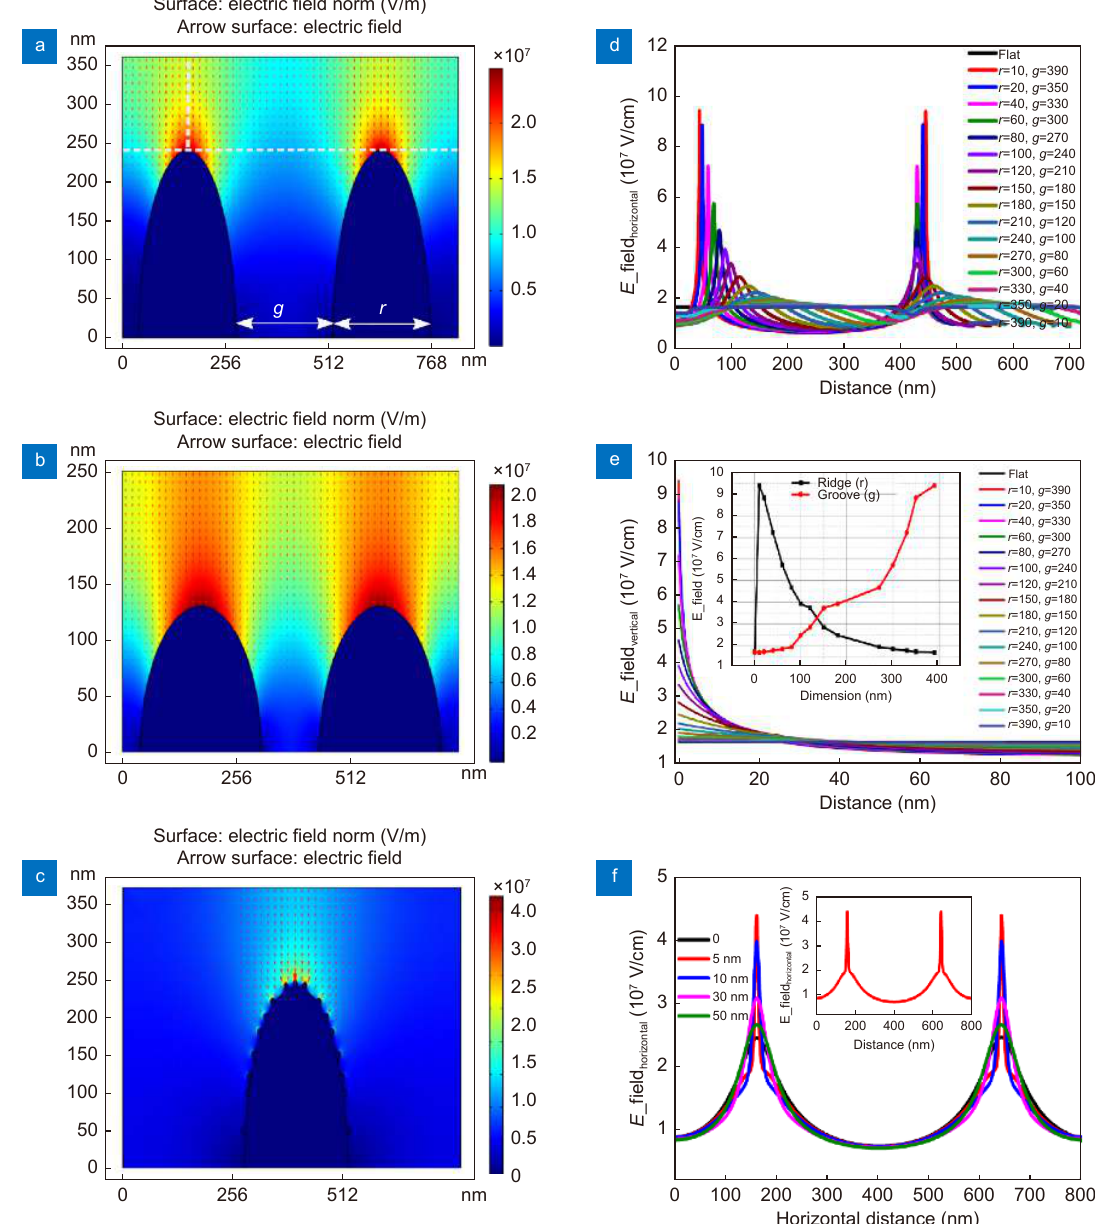
Fig. 2 | Finite Element Model (FEM) simulation for the spatial distribution of the electric fields around the ridges and grooves of –1 V biased LIPSS patterns . Electric field mapping without considering nanoparticles on the ridges and grooves with geometric parameters ( a ) g :180 nm, r :150 nm, and h : 240 nm, and ( b ) g : 100 nm, r : 240 nm and h : 125 nm, and ( c ) with the addition of 5 nm nanoparticles at the ridge. Electric field intensity along the ( d ) horizontal and ( e ) vertical dotted lines, shown in (a), for LIPSSs patterns of different geometric parameters without nanoparticles, inset of (e) showing the variation in the electric field intensity with respect to dimension of ridges and groove. ( f ) Spatial variation in the electric field intensity along the horizontal dotted line for the LIPSS pattern shown in (a) with the addition of spherical nanoparticles of differ- ent